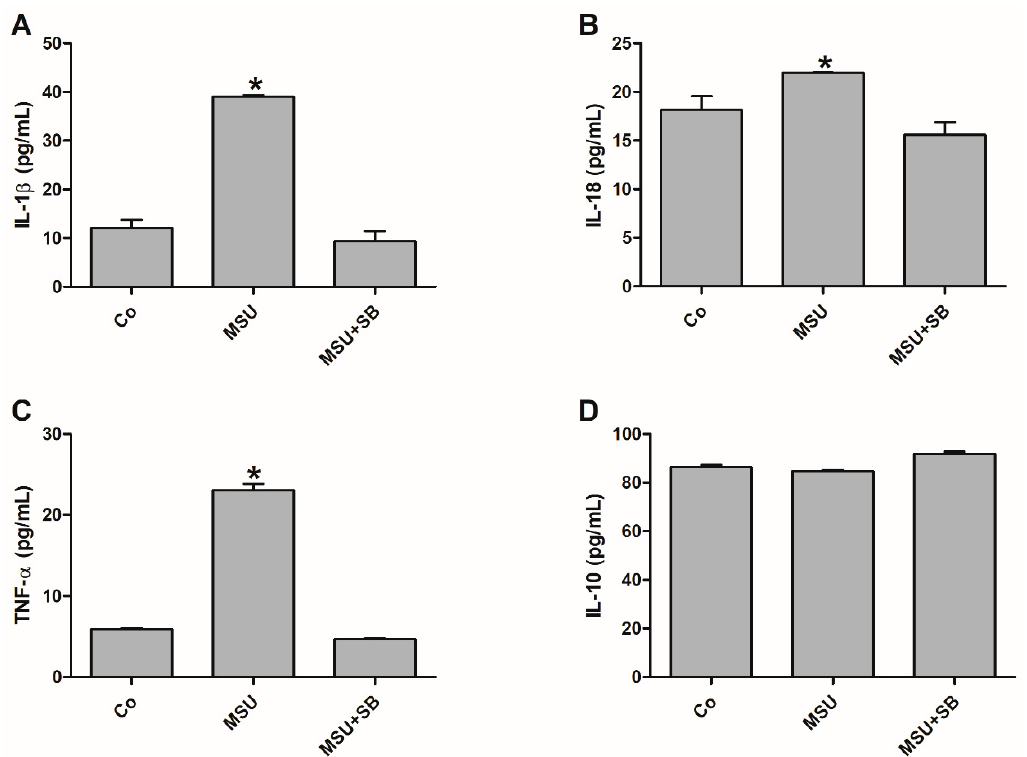
Figure 6. IL-1 β ( A ), IL-18 ( B ), TNF- α ( C ) and IL-10 ( D ) production by THP-1 cells cultured in the absence (Co) or presence of MSU or silibinin (SB). Results, obtained from five independent experiments, are shown as mean ± SD in arbitrary units (a.u.). * p < 0.05 vs. Co, MSU + SB (ANOVA).